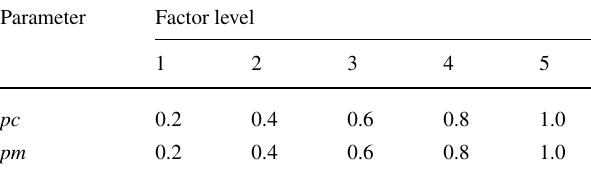
Table 3 Parameter